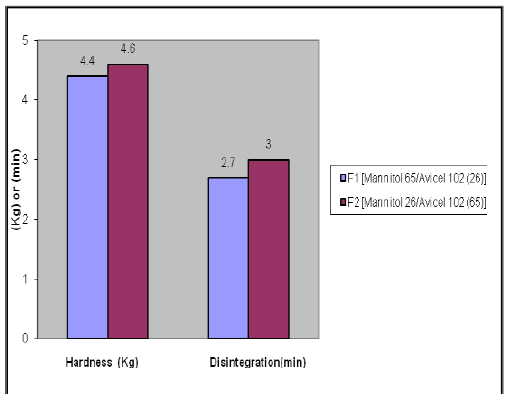
Figure 5: The effect of diluent proportion on hardness and disintegration time of formulas F1 (Mannitol 65 mg/ Avicel (102) 26 mg) and F2 (Mannitol 26 mg/ Avicel (102) 65 mg) Bisoprolol